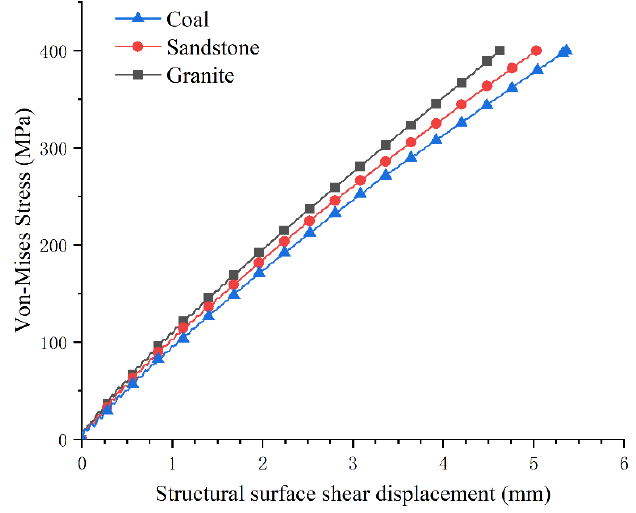
Figure 5. Curve of Von Mises equivalent stress–shear displacement of structural surface.